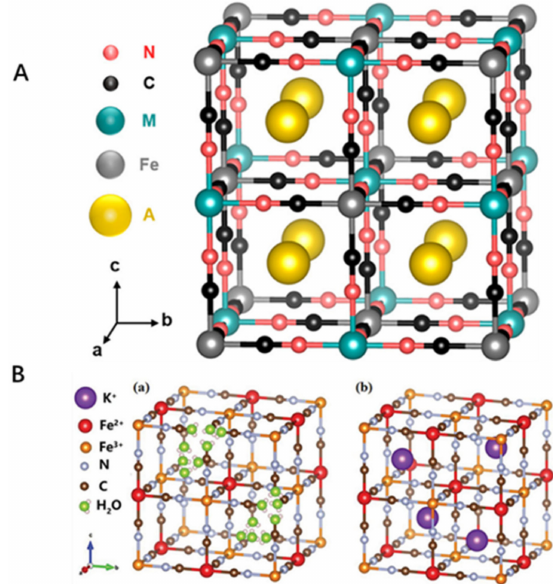
Figure 1. ( A ): Crystal structures of PBA unit cell. The general formula is A 2 MFe II (CN) 6 (A = alkali metal ion; M = divalent transition metal ion) [18]. ( B ): The two main PB forms are: ( a ) insoluble PB crystal, ( b ) soluble PB crystal [14]. “Reprinted (adapted) with permission from [18] Copyright [18] American Chemical Society.” Copyright application has been